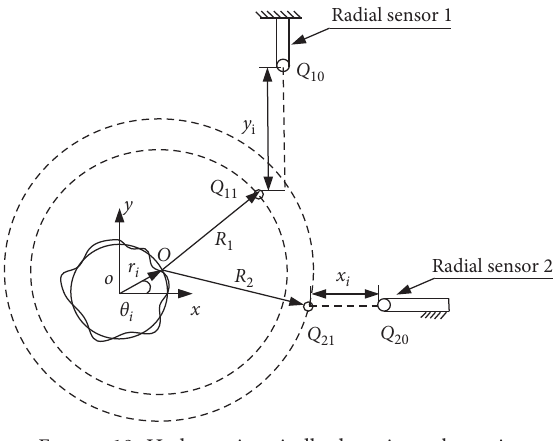
Figure 19: Hydrostatic spindle detection schematic. Figure 20: Least squares evaluation method